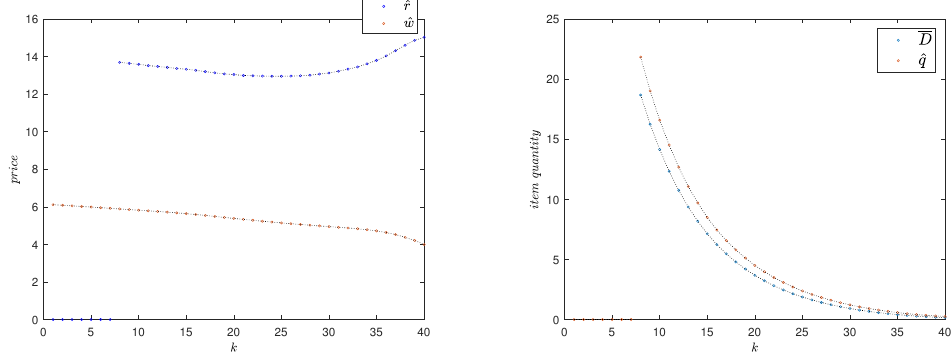
Figure 1. Pricing and supply quantities at equilibrium states in Example